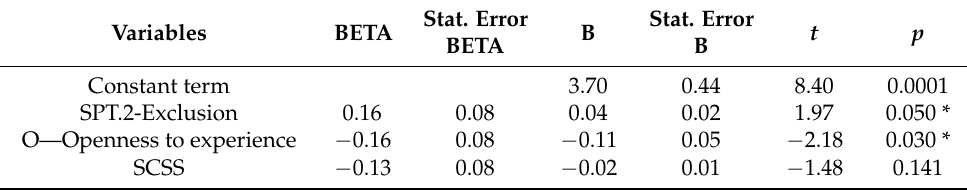
Table 12. Determinants of the ‘protective buffering’ variable.